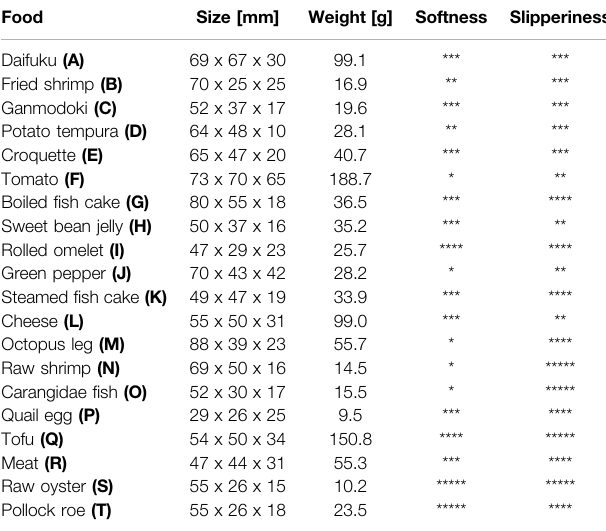
TABLE 2 | Physical properties of the food items used in the handling tests. The size is described as Length x Width x Height; the maximum value of each dimension is provided. Softness and slipperiness were qualitatively rated by star marks with fi ve stars indicating the strongest properties. Bold letters of A, B, C, ... correspond to the food item labels in Figure 9 .